Question: Express in one sentence what the figure is showing.
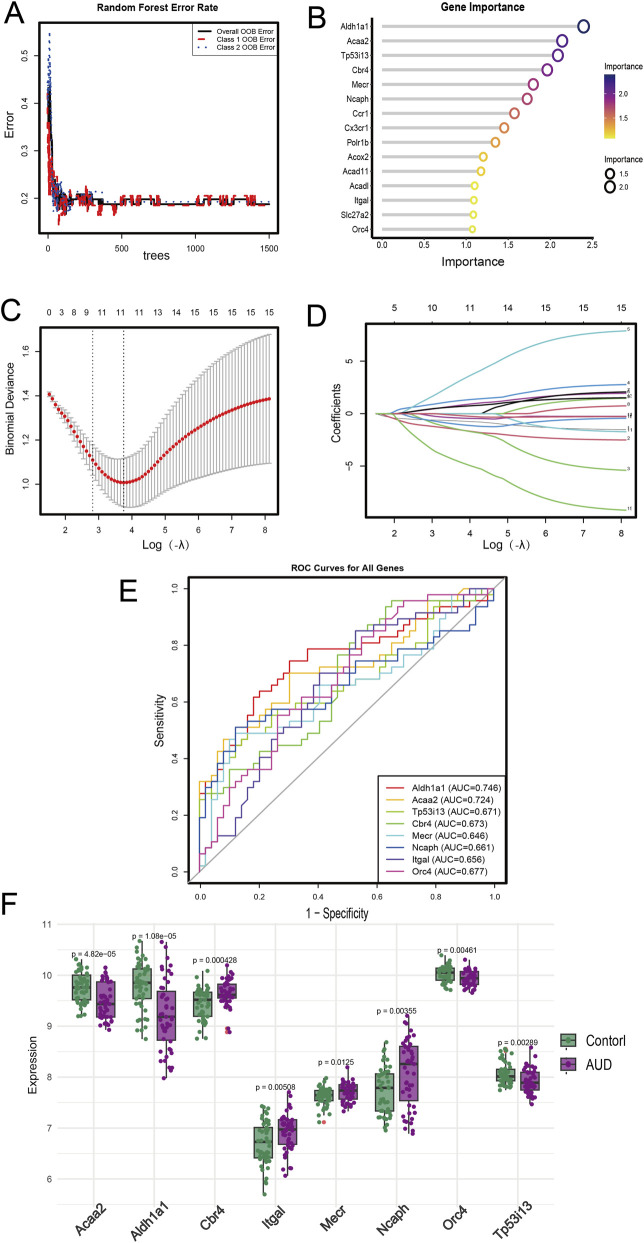
Answer: Identification of key genes associated with AUD. (A,B) Top 15 genes identified from hub genes using the random forest (RF) algorithm based on importance ranking. (C,D) Eight key genes with Non-zero coefficients identified from the 15 genes via LASSO regression (λ = 3.31). (E) Receiver operating characteristic (ROC) curves of the eight key genes, all with AUC > 0.65, indicating good diagnostic efficacy for AUD. (F) Boxplots of the eight key genes based on unpaired t-tests.